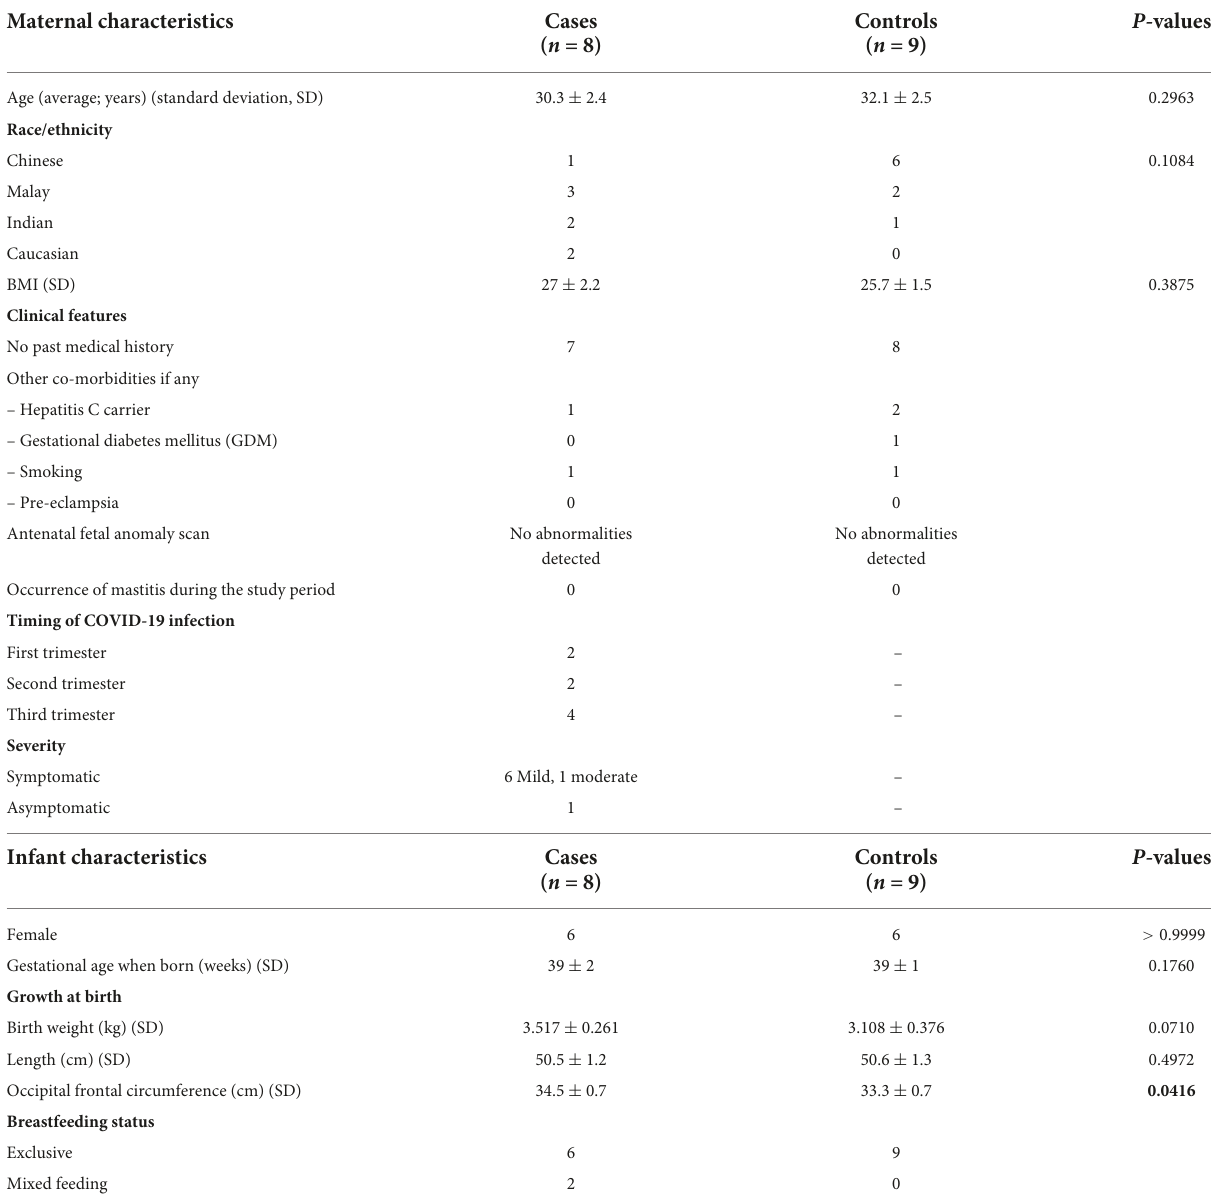
TABLE 1 Demographic and clinical characteristics of the cohort. Maternal characteristics Cases